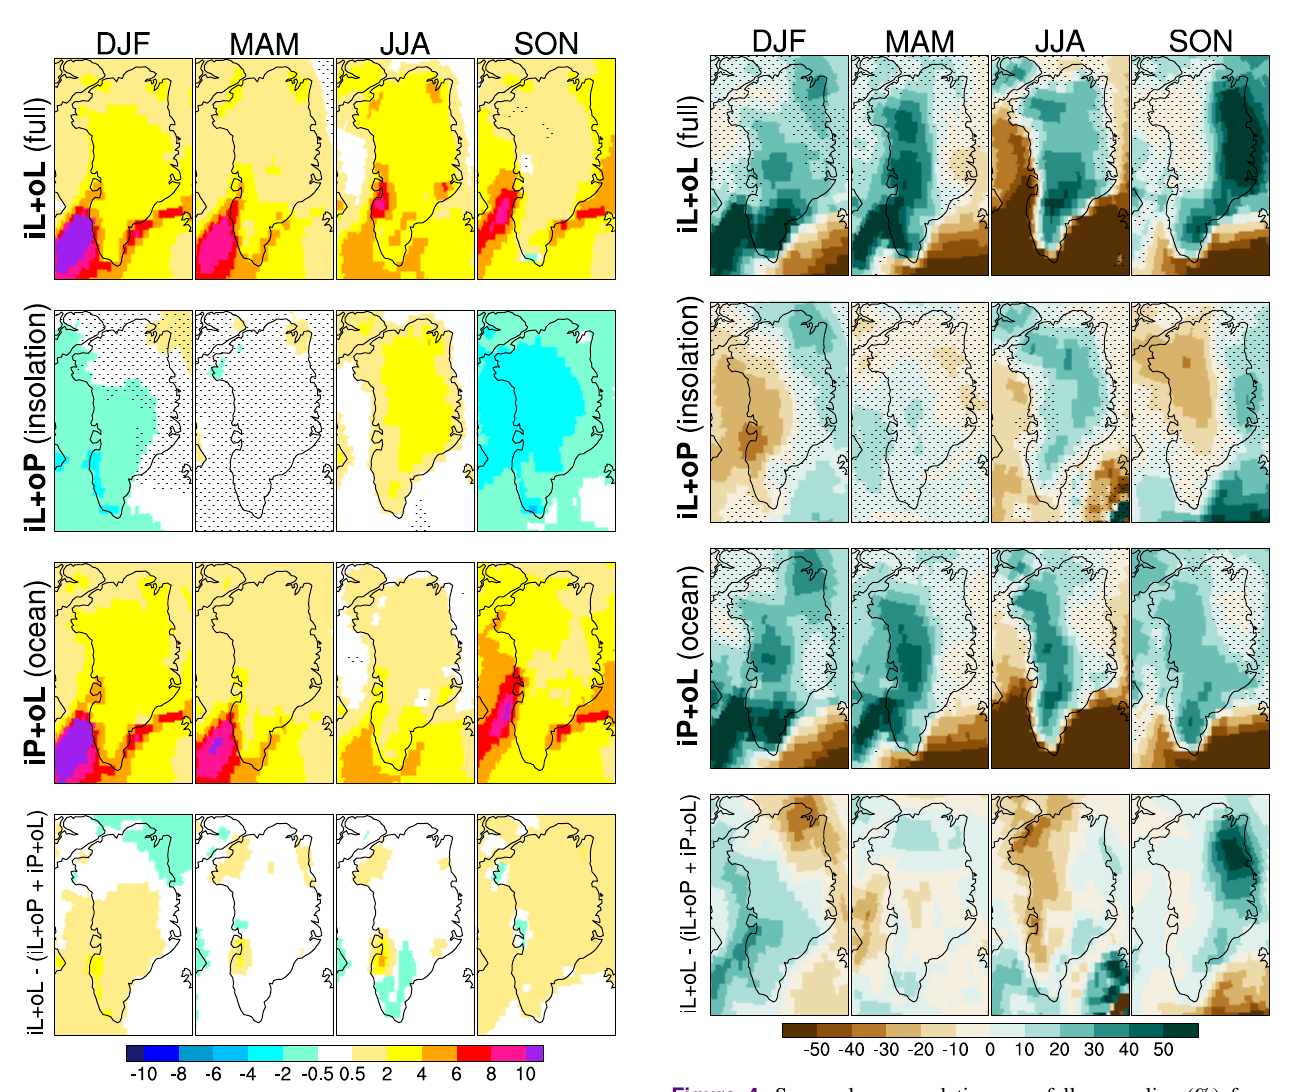
Figure 3. Seasonal mean near-surface temperature anomalies (K) compared to iP+oP in the three experiments: iL+oL (top row), iL+oP (second row), iP+oL (third row), and the difference iL+oL − (iL+oP + iP+oL) (bottom row). Here and in Figs. 4–6, bold la- beling denotes simulations/experiments, and derived fields are dis- played in standard font. Black dotted shading marks anomalies that are not statistically significant at the 95% level.